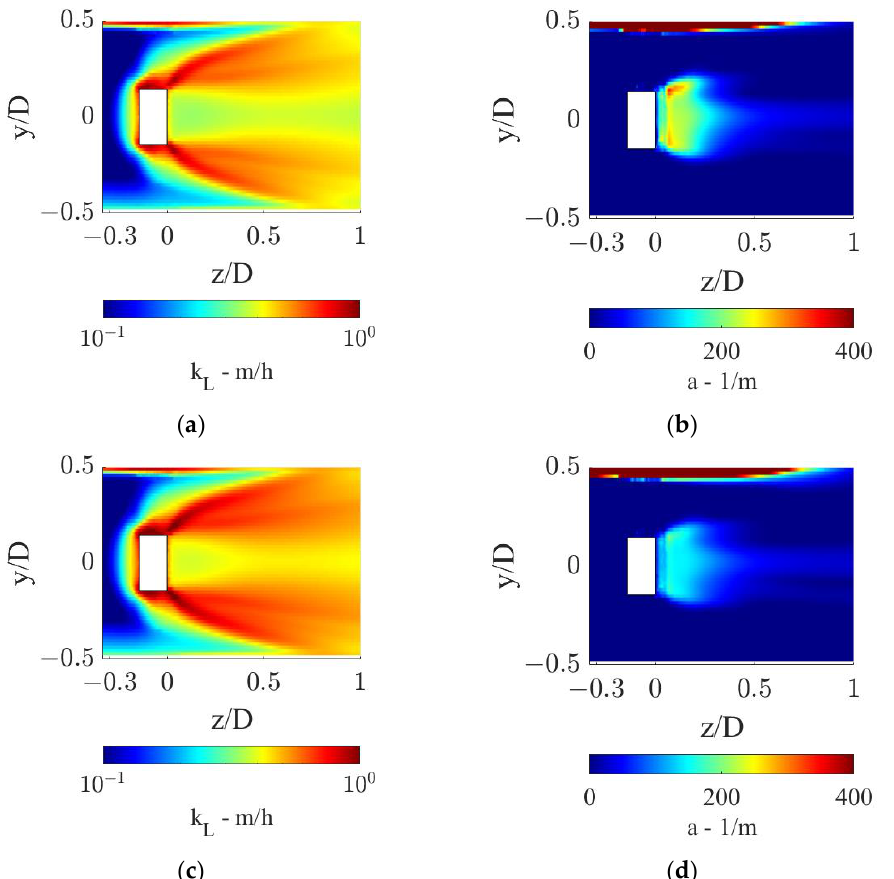
Figure 10. k L and a distributions in the proximity of the static mixer for the two operative conditions considered: ( a , b ) Q L = 25 m 3 /h and Q G = 3.75 L/min and ( c , d ) Q L = 30 m 3 /h and Q G = 7.5 L/min. considered: ( a , b ) Q 3 /h and Q L = 25 m G = 3.75 L/min and ( c , d ) Q L = 30 m